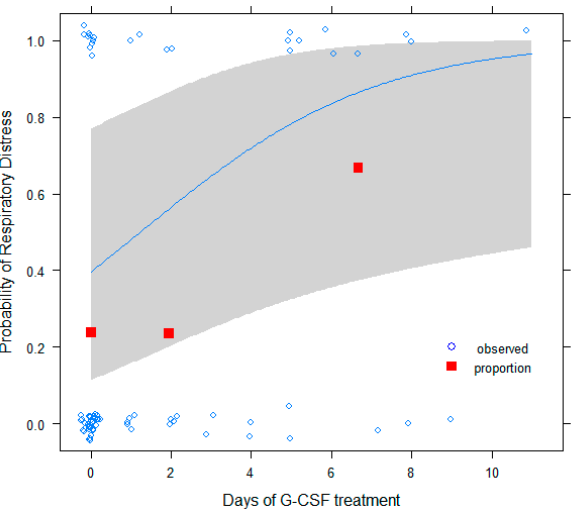
Figure 2. Respiratory distress as a function of G-CSF treatment days: observed data (open circles, fitted to ease visualization), proportions (red squares, in subgroups of <1, 1–4, and >4 days), and fitted logistic model with 95% confidence bands are shown.